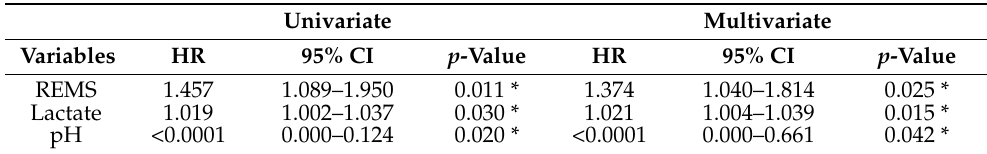
Table 5. Hazard ratios and 95% confidence interval of univariate and multivariate logistic regression analysis for emphysematous